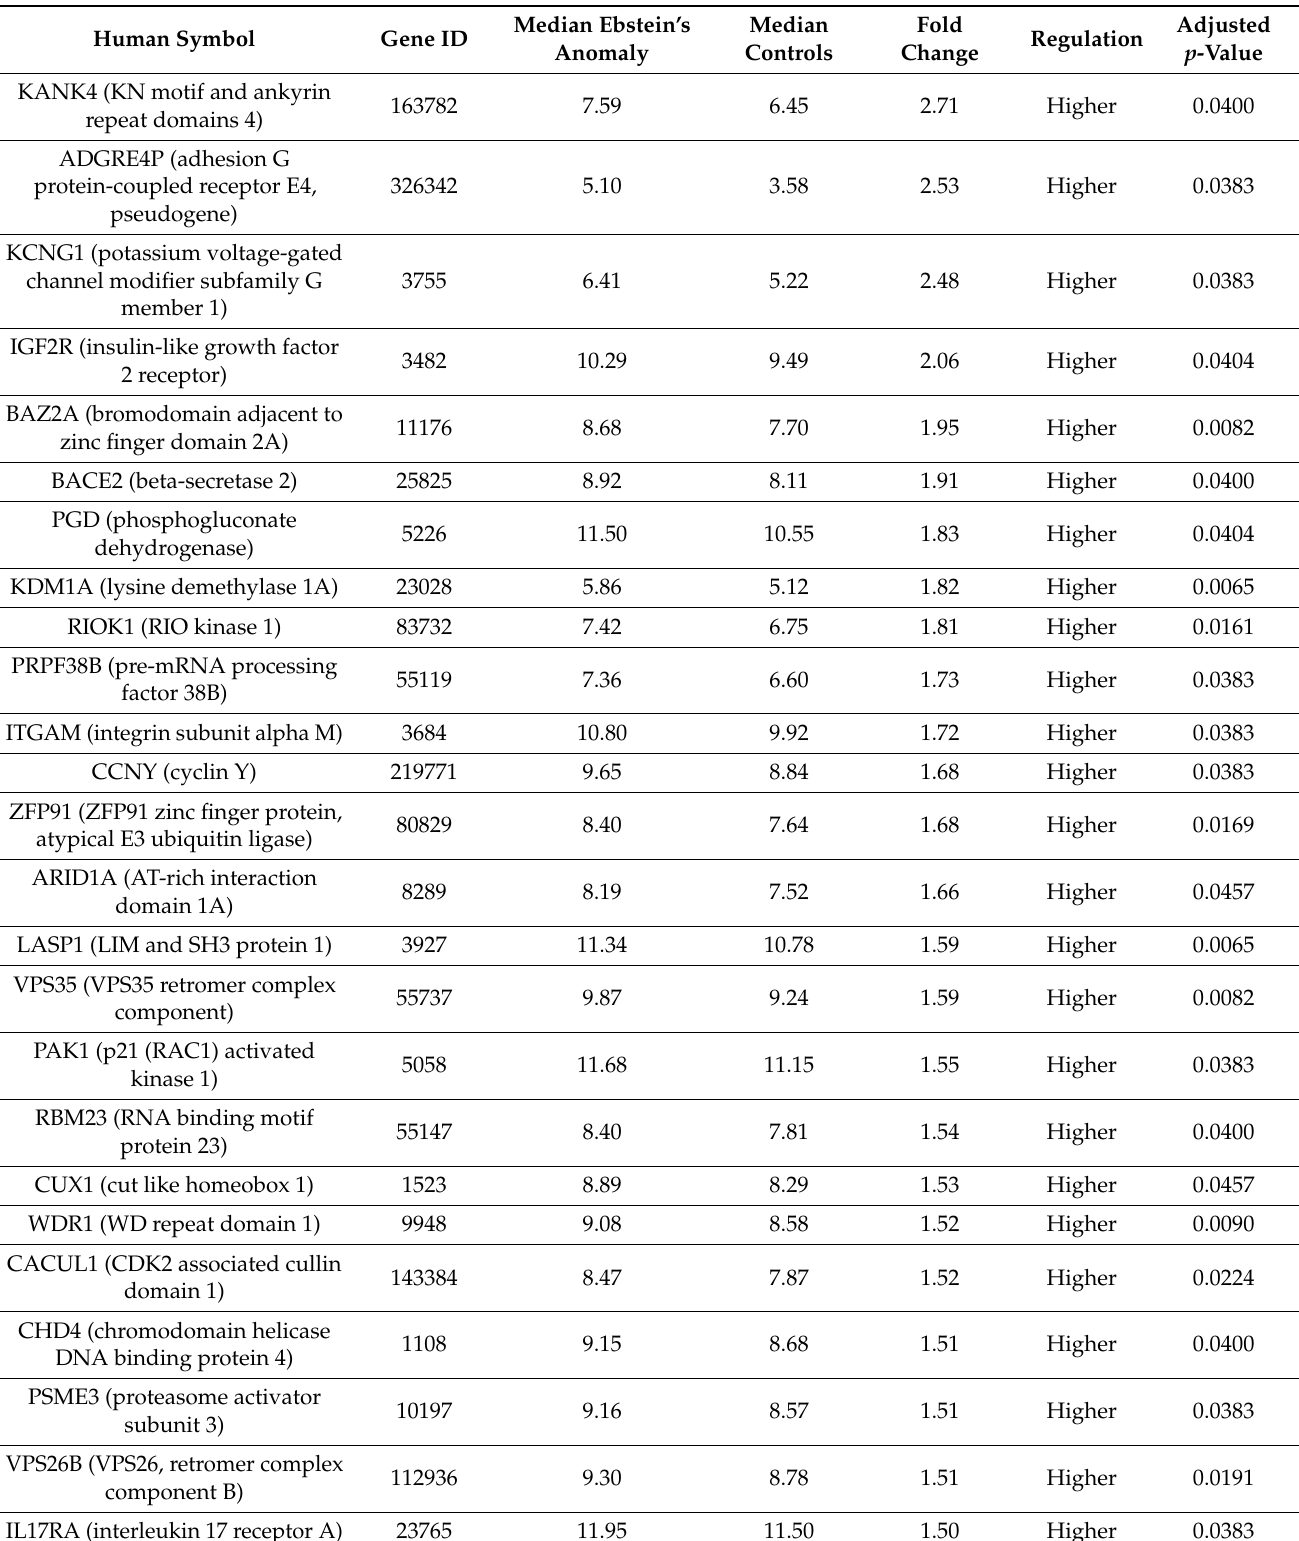
Table 2. Significantly abundant transcripts in the blood of patients with Ebstein’s anomaly compared to healthy controls as determined by